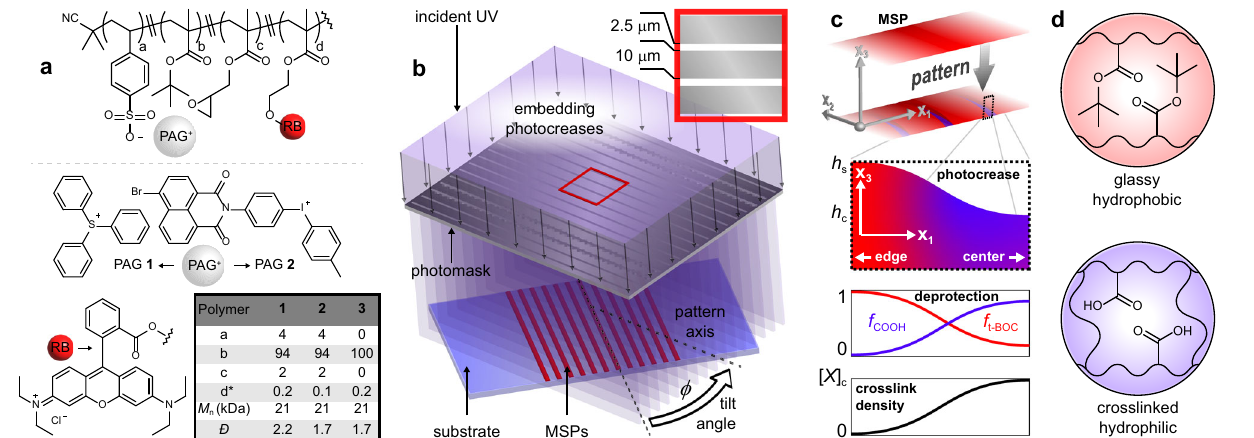
Fig. 2 | Strategy for embedding photocreases into MSPs. a Random copolymer structure used in this study, where the counter ion is sulfonium (PAG 1 ) or iodo- nium(PAG 2 )andRBrepresentstherhodamineB fl uorophore.Incorporationratios a – c were determined by 1 H NMR peak integration while d was estimated from the feed ratio; molecular weight distributions were estimated by gel permeation